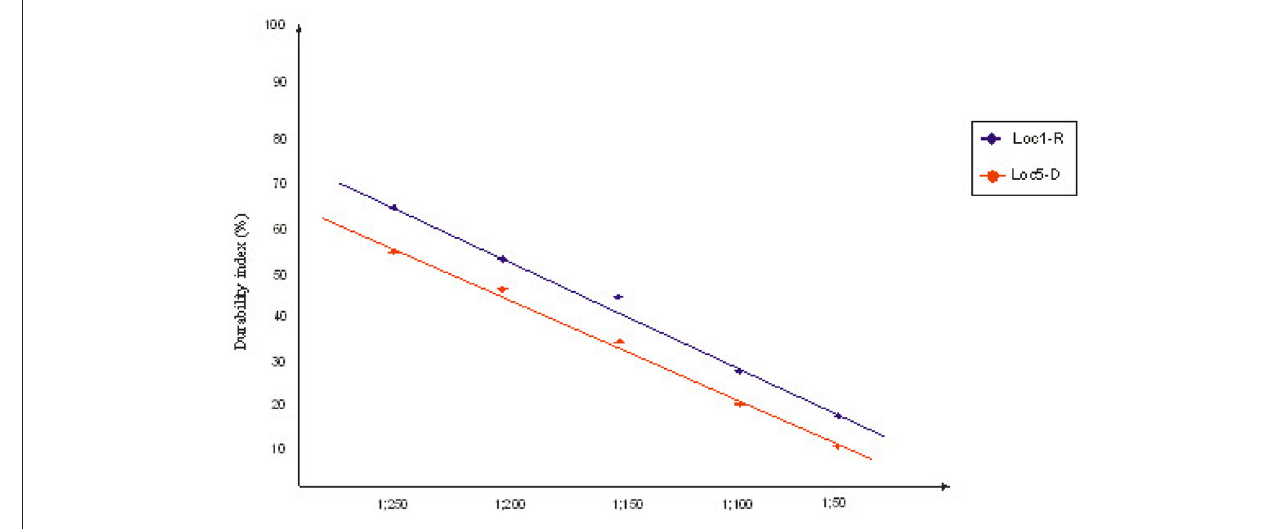
FIGURE 12 | Durability test (source: analysis of laboratory results).